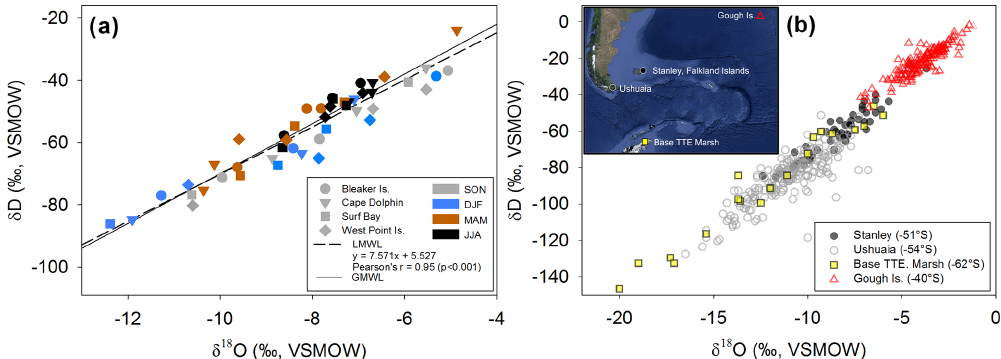
Figure 4. (a) δ 18 O and δ D (‰, VSMOW) isotopes in precipitation for each Falkland Islands location (symbol shape) during four seasons (symbol color). The constructed local meteoric water line (LMWL; y = 7 . 571 x + 5 . 527; r = 0 . 95; p < 0 . 001) is shown as a dashed line and global meteoric water line (GMWL: δ D = 8.0 δ 18 O + 10) is a solid line. (b) Regional variation of δ 18 O and in δ D in precipitation illustrating the variability in precipitation isotopes in the South Atlantic region. Corresponding locations of Global Network of Isotopes in Precipitation (GNIP) sites and potential sources of precipitation origin throughout the region over 30 years of data collection. Data from Stanley, Falkland Islands, spans from 1962 to 1979; Ushuaia, Argentina, from 1982 to 2002; Teniente Rodolfo Marsh Martin Base, Antarctica (Base TTE Marsh) from 1990 to 1991; and Gough Island from 1961 to 2009. Data were downloaded from GNIP at https://nucleus.iaea.org/wiser (last access: 3 September 2020). Map data: © 2018 Google, SIO, NOAA, U.S. Navy, NGA, and